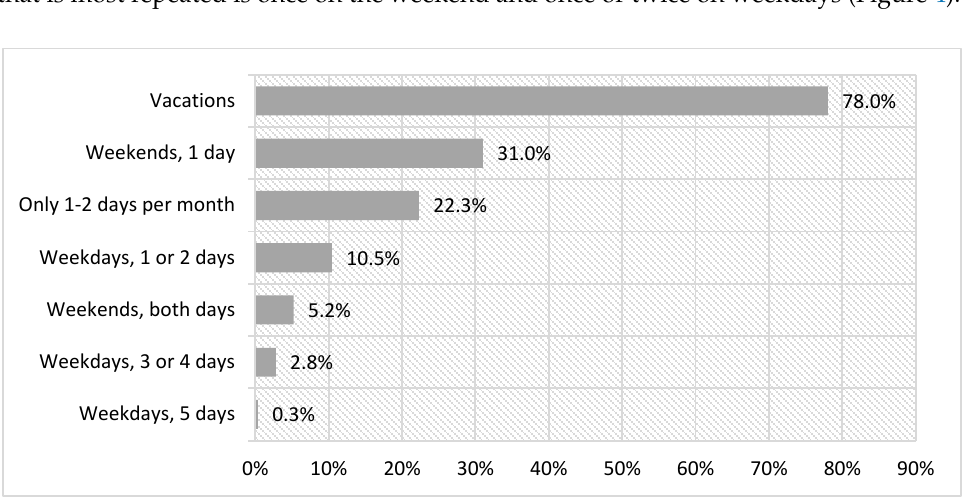
Figure 3. Festive leisure activities practiced.